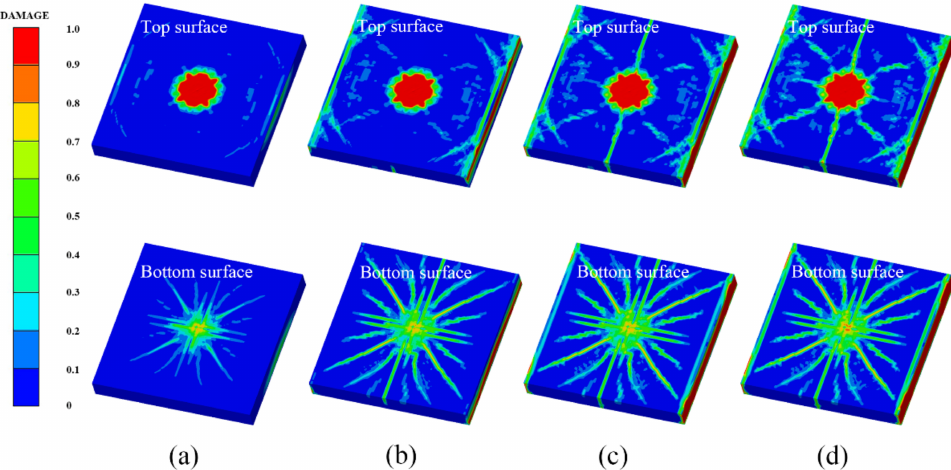
Figure 20. Damage process of the SPH–FEM coupling model: ( a ) 0.3 ms, ( b ) 0.9 ms, ( c ) 1.5 ms, ( d ) 2.0